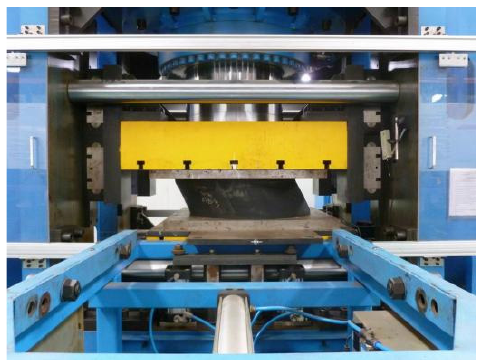
Figure 7. Loading test machine.